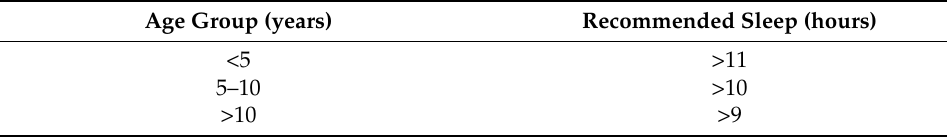
Table 1. Recommended sleep duration hours.